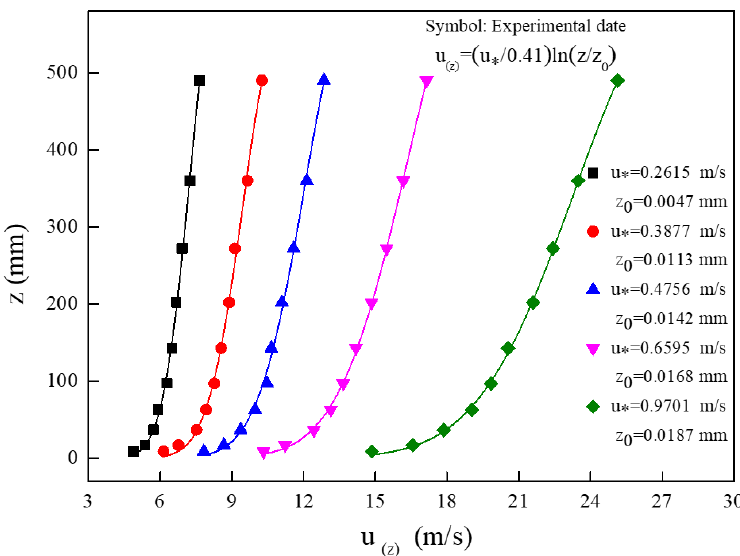
Figure 6. Wind profiles with experimental data and the profile curves fitted to the logarithmical